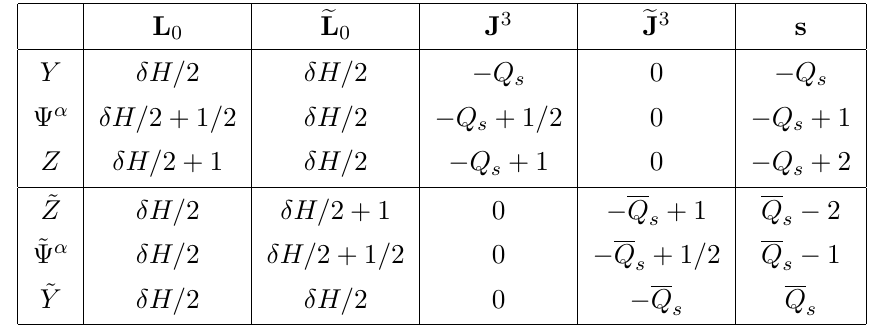
Table 1 . Charges of the massive particles and their string theory bound states under the Cartan elements. Q denotes the mass of the left bound state, with Q s Similarly, Q denotes the mass of the right bound state, with Q s